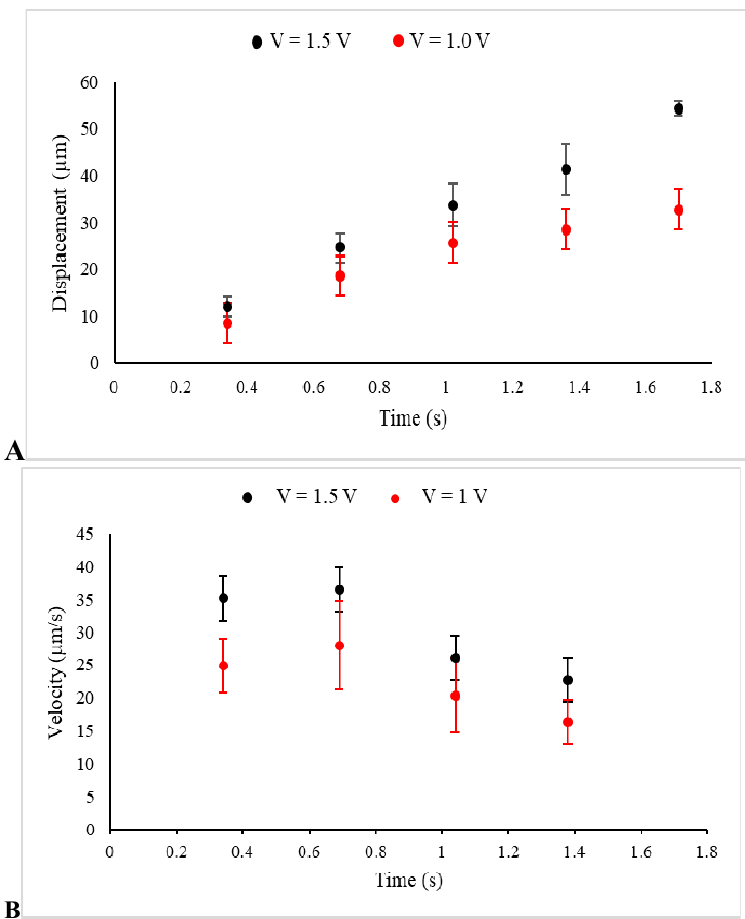
Figure 3. The displacements ( A ) and the velocities ( B ) of beads in a kinesin-free environment and under electric fields between electrodes, created by the voltages 1.5 V (Black) and 1 V (Red) in these sets of control experiments, are presented.